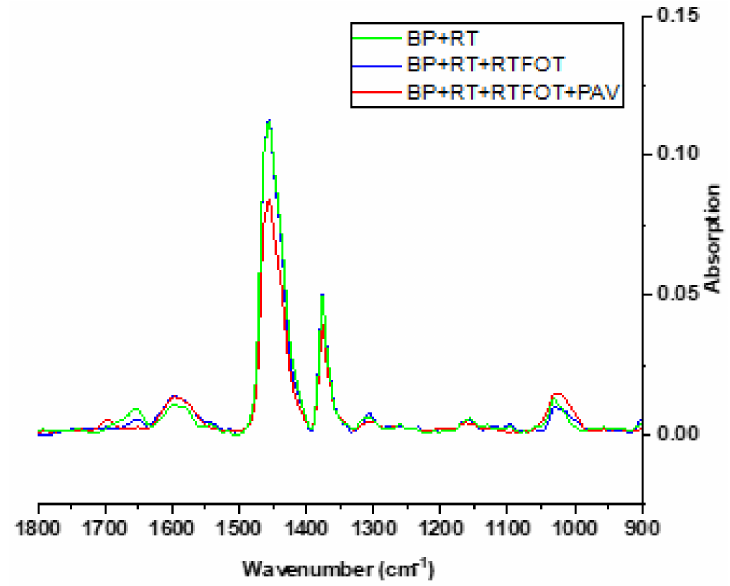
Figure 11. FTIR spectra for BP + RT at all ageing